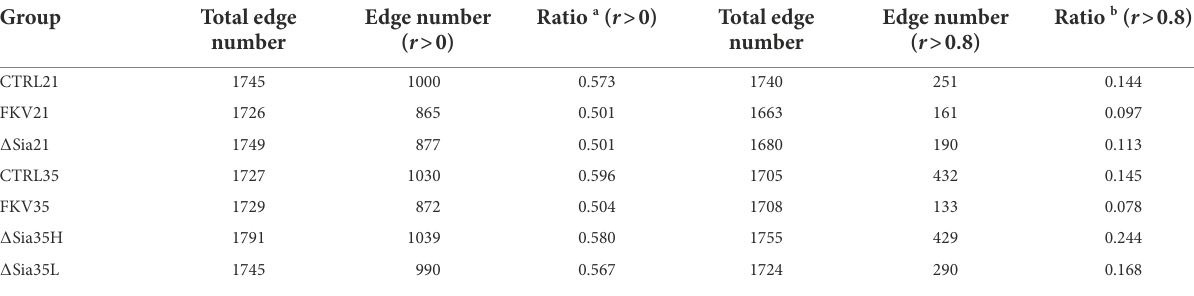
a Represents the ratio of edge numbers with r > 0 to the total edge numbers. b Represents the ratio of edge numbers with r > 0.8 to the total edge numbers. CTRL21, control group at 21 dpiv; FKV21, FKV group at 21 dpiv; ∆ Sia21, LAV ∆ Sia group at 21 dpiv; CTRL35, control group at 35 dpiv; FKV35, FKV vaccine group at 35 dpiv (14 days after the second immunization); ∆ Sia35H, LAV ∆ Sia group with a high serum antibody response at 35 dpiv (14 days after the second immunization); ∆ Sia35L, LAV ∆ Sia group with a low serum antibody response at 35